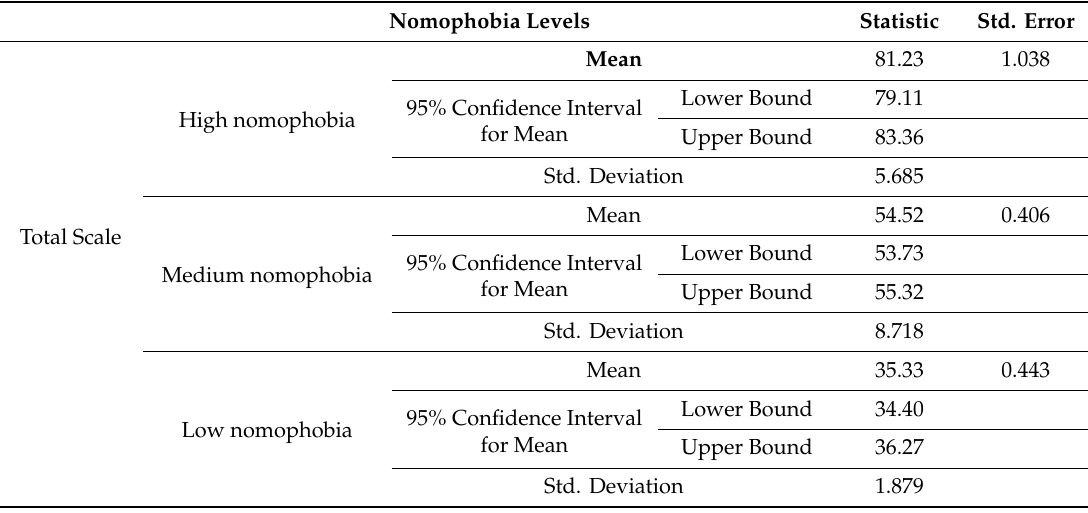
Table 4. Descriptive statistics of three groups of nomophobia (taking, with reference, the total scale). Nomophobia Levels Statistic Std.